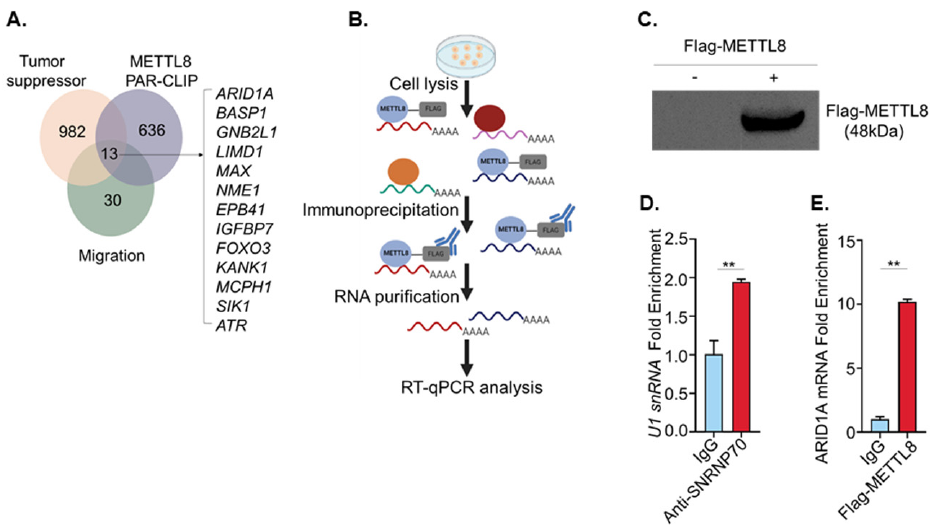
Figure 4. ( A ) Venn diagram showing mRNAs that bind to METTL8 via a putative target gene list of METTL8(11), a tumor suppressor genes list (18), and a list of cancer migration-related genes. ( B ) Schematic summary of the RIP protocol followed by RT-qPCR were created in BioRender.com. ( C ) Western blot shows the expression of Flag-tagged METTL8 protein in the RIP lysate. ( D ) RT-qPCR detection of positive control U1 snRNA in RNAs enriched by anti-snRNP70 RIP. ** indicates p < 0.01. ( E ) ARID1A mRNA was highly enriched in the RNAs enriched by anti-Flag METTL8 RIP by RT-qPCR. MDA-MB-231 cells were subjected to RIP assay after transfection with Flag-tagged METTL8 cDNA ORF Clone. ** indicates p < 0.01.